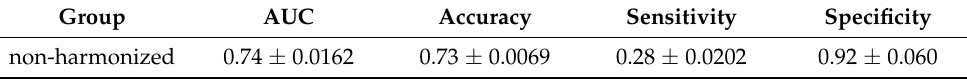
Table 8. Results for a K-Fold Stratified Cross Validation using the LASSO